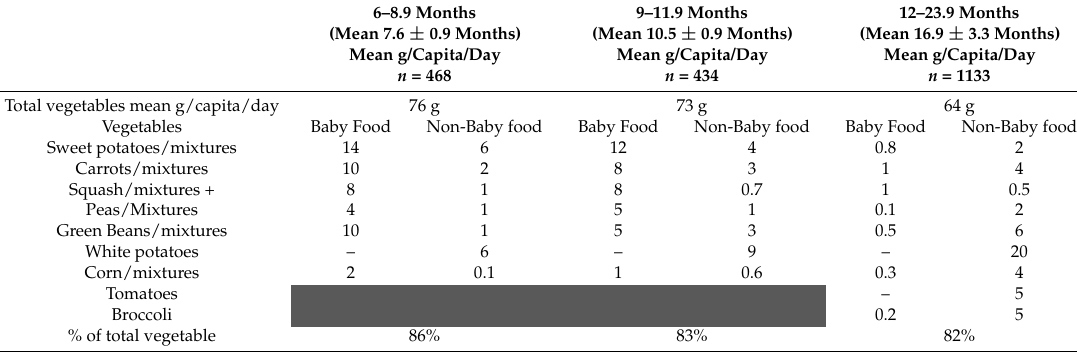
Table 3. Top Vegetables Consumed by Age Range in Mean grams Per Capita: FITS 2016